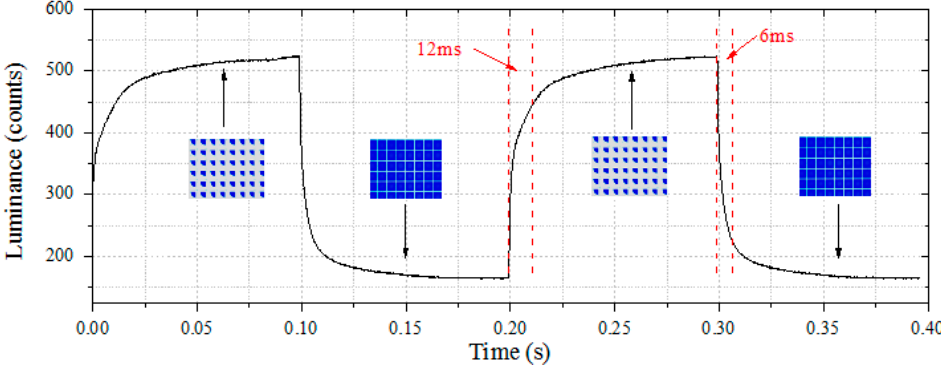
Figure 8. Optical response of EFD measured by a colorimeter. Forty volts of DC voltage was applied at a duty cycle of 50% and 5 Hz frequency (100 ms on/100 ms off). Insets show the optical microscope images of “On” and “Off” states. In this case, the “on” switching time is about 12 ms, and the “off” switching time is 6 ms (corresponding to 80% of maximum change).